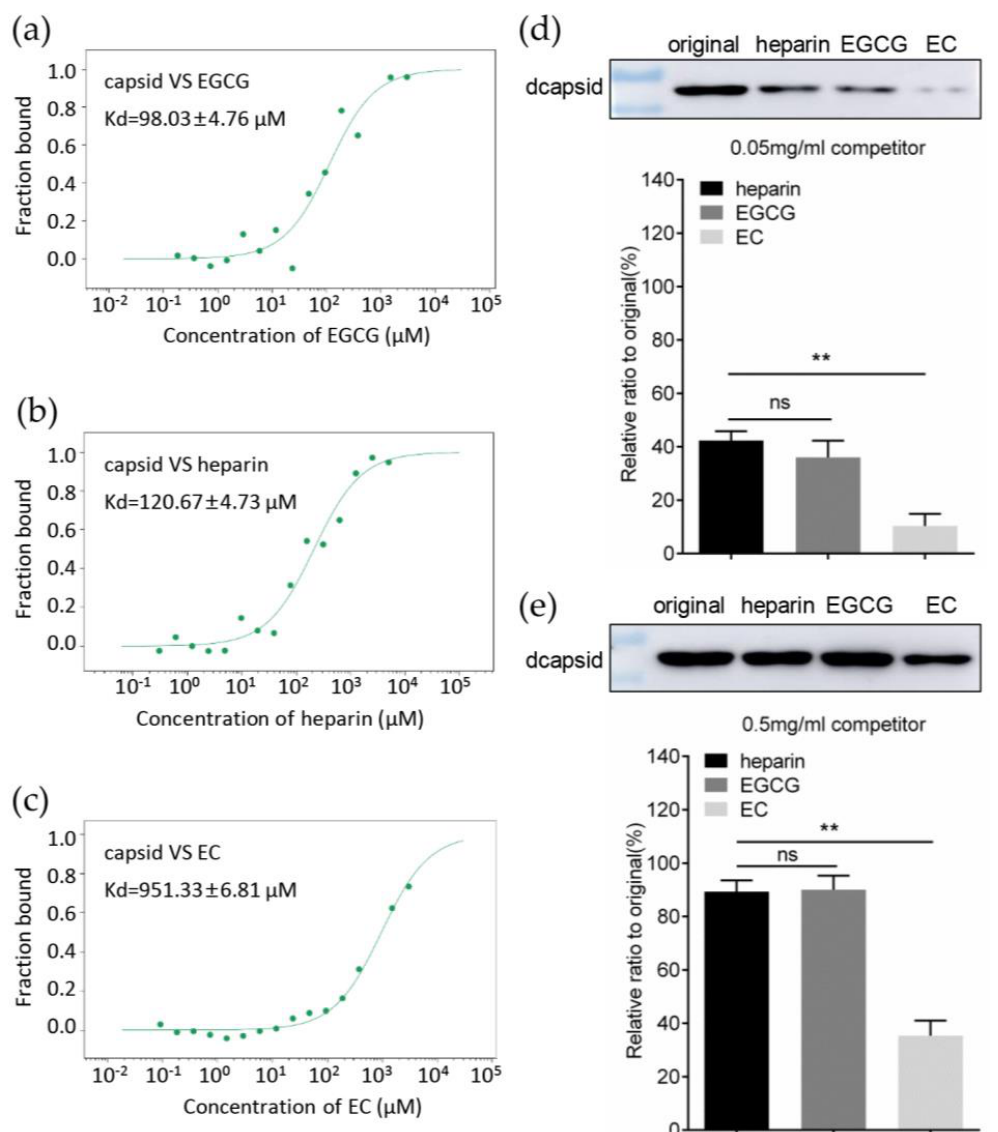
Figure 4. EGCG competitively inhibited capsid binding to heparan sulfate. ( a – c ) EGCG could interact with capsid or with heparin. The dcapsid protein was labeled with the Cy5 fluorophore and incubated with two-fold serial dilutions of EGCG or heprarin (10–50 nM), and then the Kd values of the dcapsid were measured for EGCG ( a ), heparin ( b ), and EC ( c ) were measured by MST. ( d , e ) EGCG eluted dcapsid protein bound to a heparin column with similar e ffi ciency as heparin. Heparin-Sepharose HP column was pre-loaded with dcapsid and eluted with 0.05 ( d ) or 0.5 ( e ) mg / mL soluble competitor reagents (heparin, EGCG and EC). The eluted samples were analyzed using SDS-PAGE and immunoblotting. Three independent experiments were conducted. The results are presented as Mean ± SD and compared using Student’s t -test (n.s., not significant; * p < 0.05; ** p <